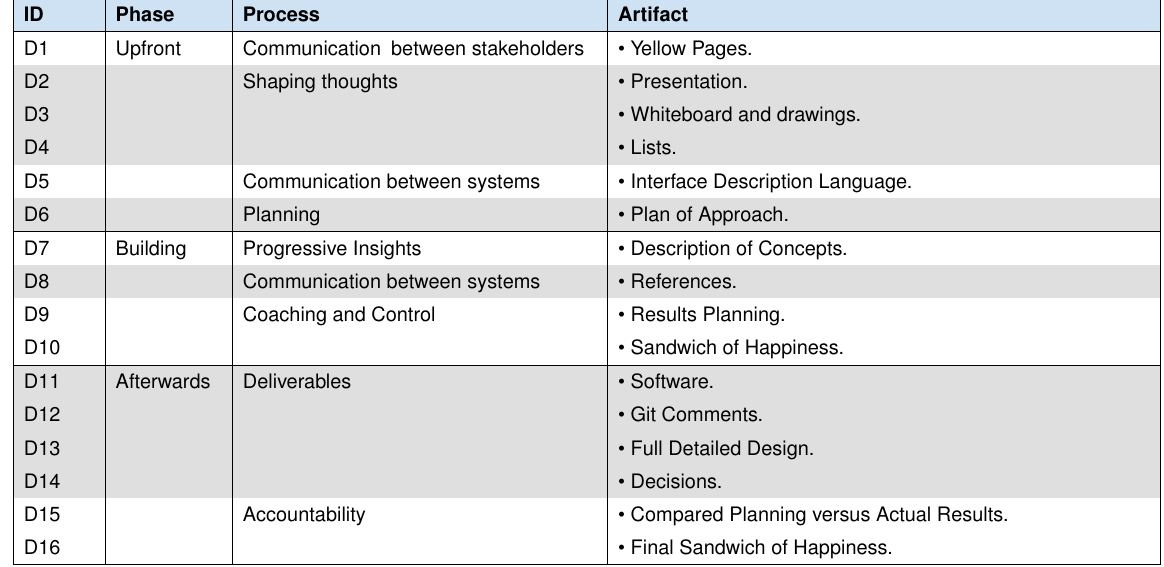
Table 1. Phases, Processes, and Artifacts in Continuous Software